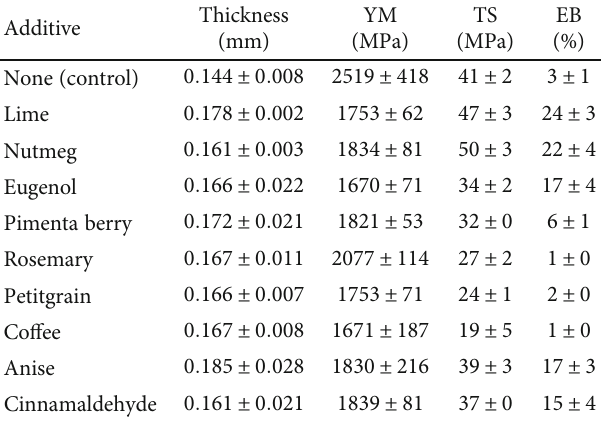
Table 2: Film thickness, Young ’ s modulus, tensile strength, and elongation at break of CA fi lms incorporated with 20% essential oils.